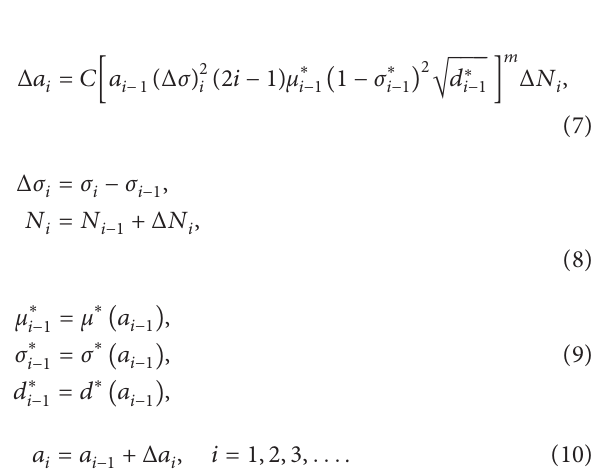
Figure 7: Schematic of fracture process of gray cast iron specimens: (a) initial condition; (b) initiation and growth of microcrack; (c) initiation and growth of macrocrack to the final break.